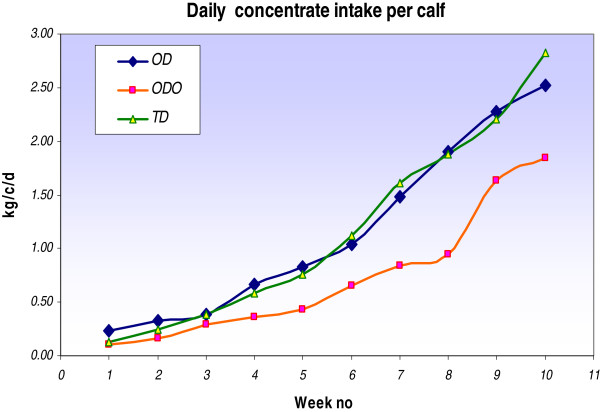
Calf intake of concentrates per day-Experiment 1.